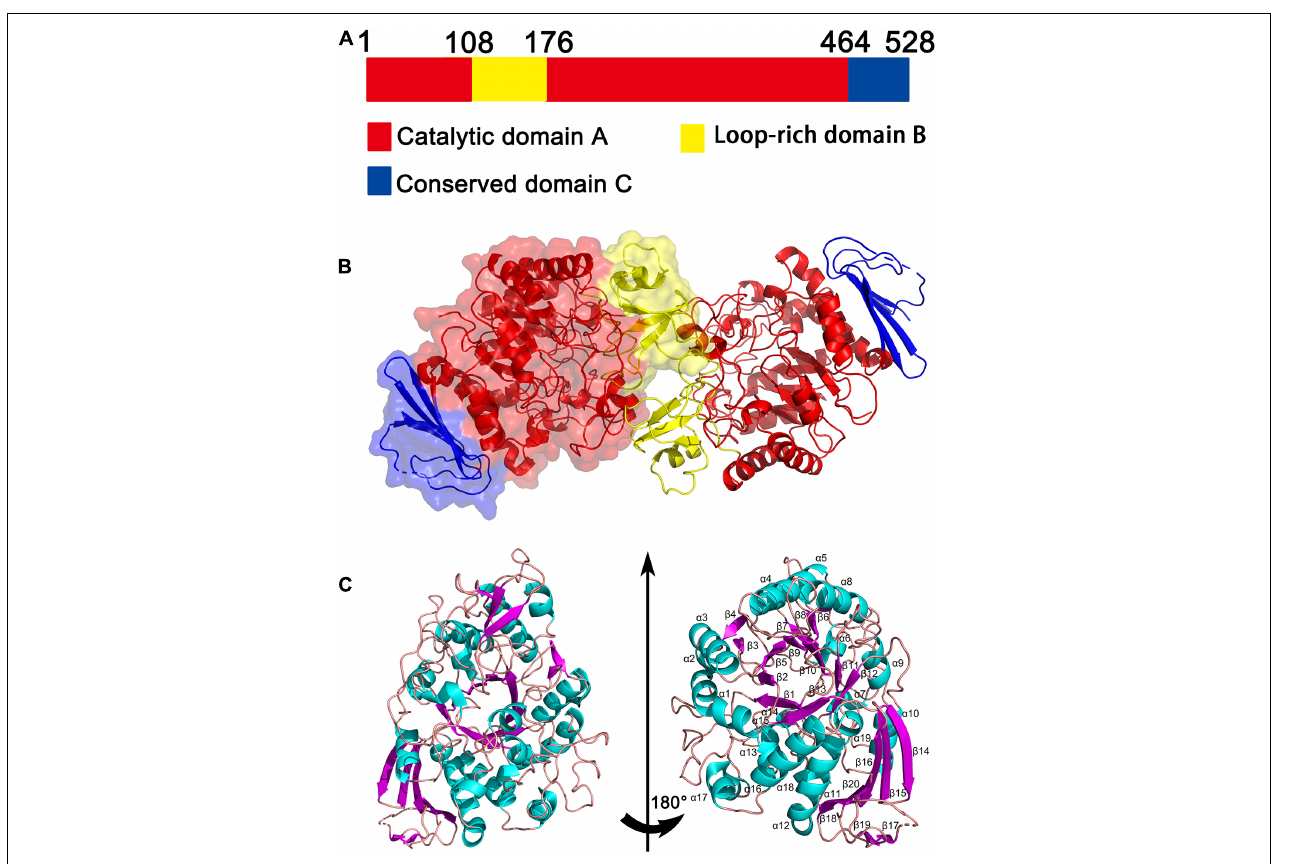
FIGURE 3 | The overall structure of QsGH13. (A) QsGH13 is composed of the catalytic domain A (red), loop-rich domain B (yellow), and conserved domain C (blue). (B) Schematic of the overall structure of the CmGH1 protein. (C) Cartoon representation of QsGH13 with the labeled secondary structure elements. α -Helices were shown in magenta; β -strands were denoted as lake blue